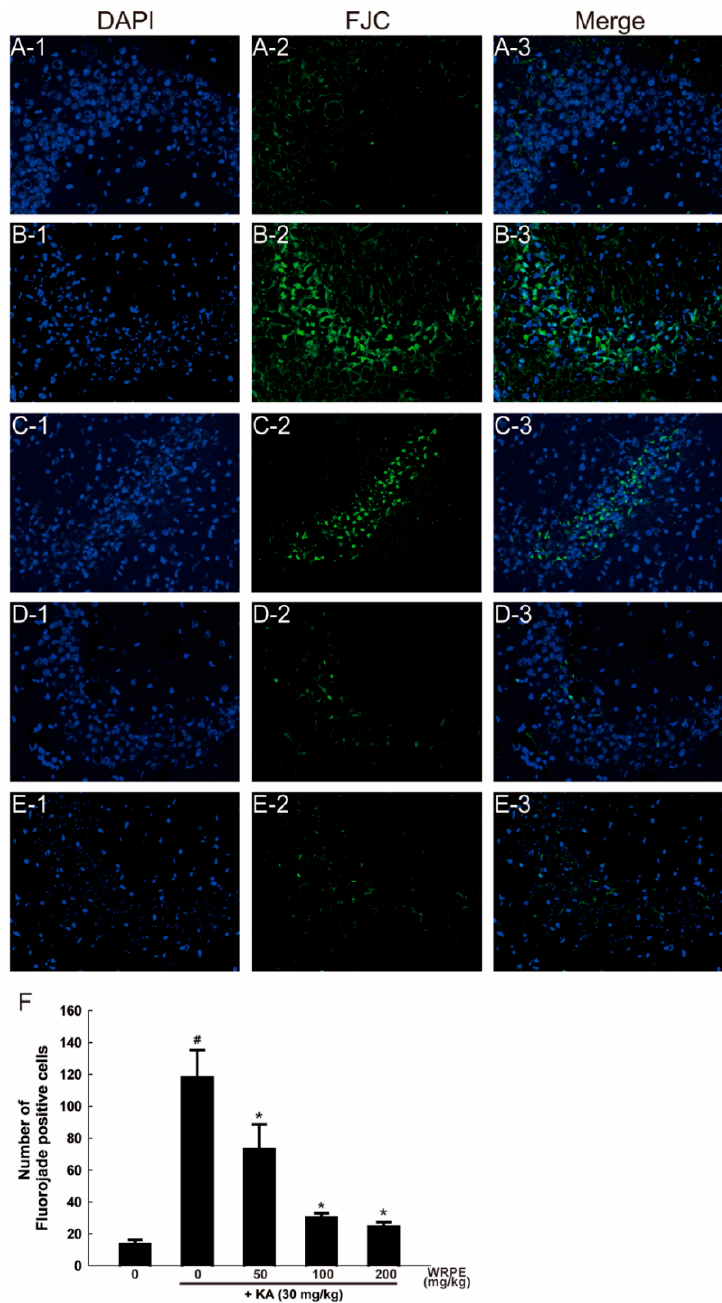
Figure 7. Neuroprotective activity of white rose petal extract (WRPE) in kainic acid (KA)-challenged mice observed by Fluorojade C (green-colored) staining, showing representative microscopic findings ( A – E ) and the number of degenerating (Fluorojade C-positive) cells ( F ). ( A ) Normal (vehicle) control, ( B ) KA (30 mg/kg) alone, ( C ) KA + WRPE (50 mg/kg), ( D ) KA + WRPE (100 mg/kg), and ( E ) KA + WRPE (200 mg/kg). ( F ) Quantification of FJC-labeled neurons in the hippocampal CA3 pyramidal cell layer. n = 3 per treatment group. # Significantly different from normal control ( p < 0.05). * Significantly different from vehicle control ( p < 0.05).